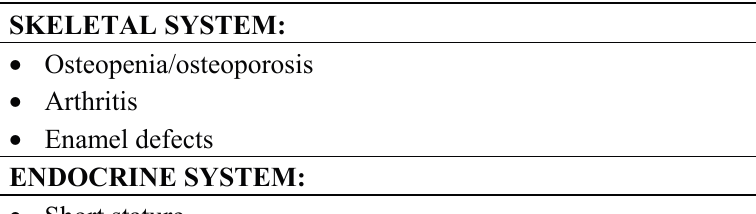
Table 1. Extraintestinal manifestations of